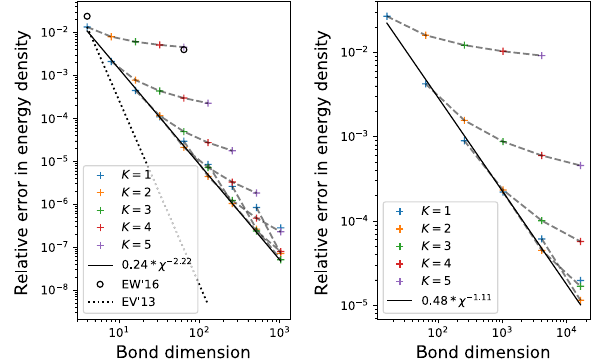
panel).FIG. 9. Relative error in the energy density for the approximate ground states prepared by our quantum circuits in one dimension (left panel) and in two dimensions (right panel), for various values of the wavelet parameters K , L (dashed lines indicate the same L ). For comparison, we also display the relative error for the analytical construction from Ref. [29] and for the numerically optimized non-Gaussian MERA from Ref.